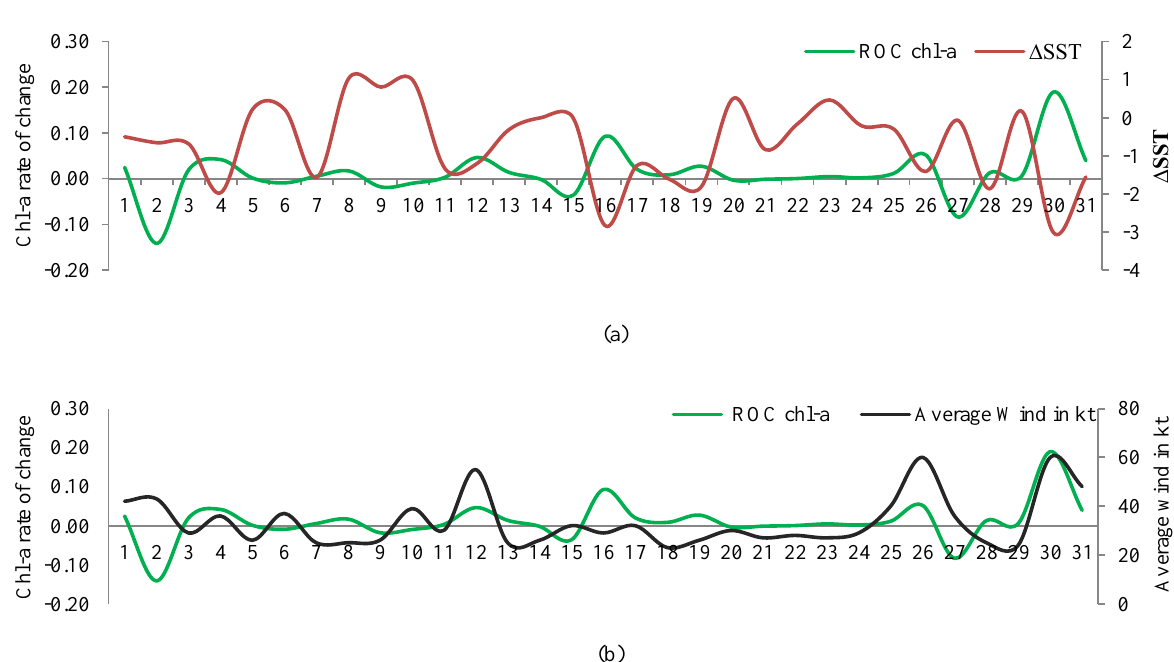
Figure 5. Comparison of (a) SST cooling response and (b) wind intensity with the chl- a . (The cyclone cases information is specified in Table 1 in ascending order as per the year